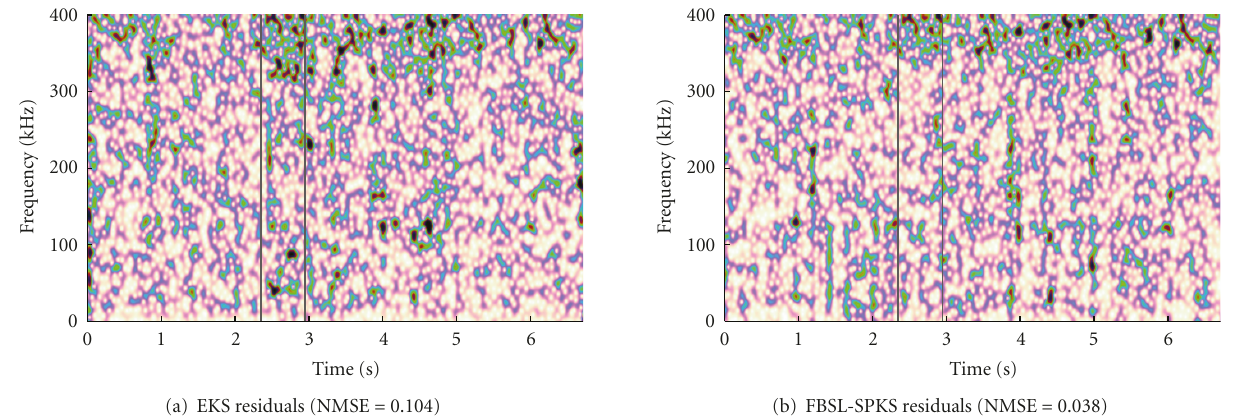
Figure 8: (a) Spectrogram of residuals using the EKS tracking of a photosensor insect activity signal. (b) Spectrogram of residuals using the FBSL-SPKS tracking of a photosensor insect activity signal.